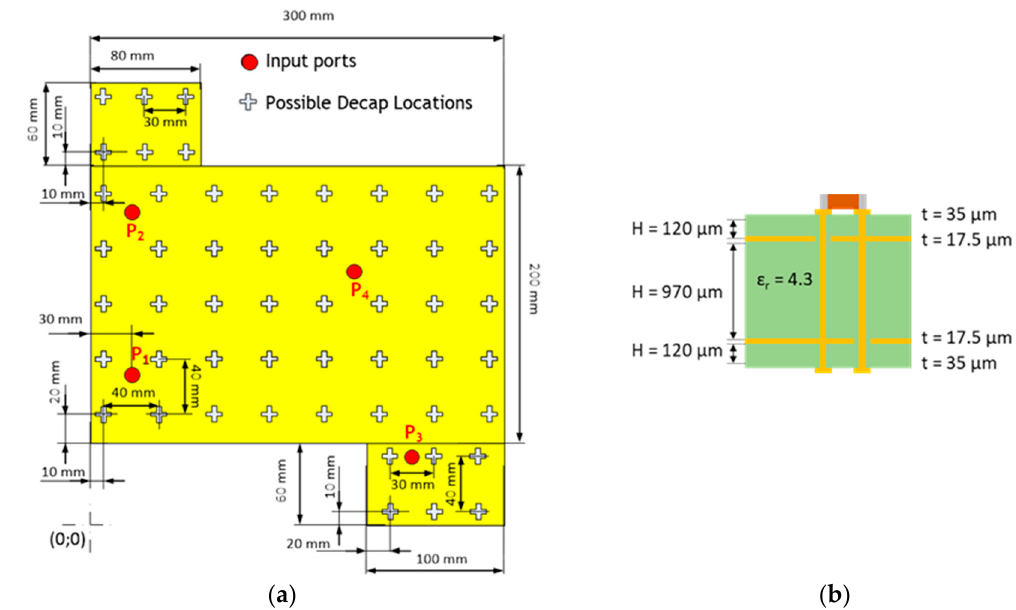
Figure 11. ( a ) The test PDN boards and ( b ) its stack-up.